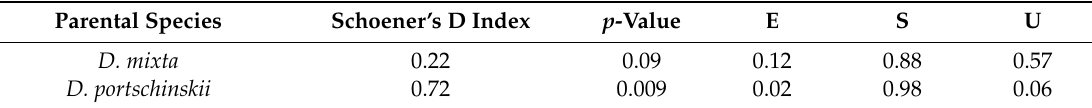
Figure 2. Niche overlaps of D. dahli , D. portschinskii and D. mixta in multidimensional space of predictor variables. Panels ( a , b ) represent the niche overlap between D. dahli and D. portschinskii along the two first axes of the PCA; ( c , d ) represent the niche overlap between D. dahli and D. mixta . Shaded areas show the density of the occurrences of D. dahli ( a , c ), D. portschinskii ( b ) and D. mixta ( d ). The solid and dashed lines illustrate, respectively, 100% and 90% of the available (background) environment. Table 3. Niche overlap assessed using Schoener’s D indices between D. dahli and parental species ( D. portschinskii and D. mixta ) ranges. Where E is expansion, S is stability, U is unfilling, p -values of the niche similarity test are given for a pairwise